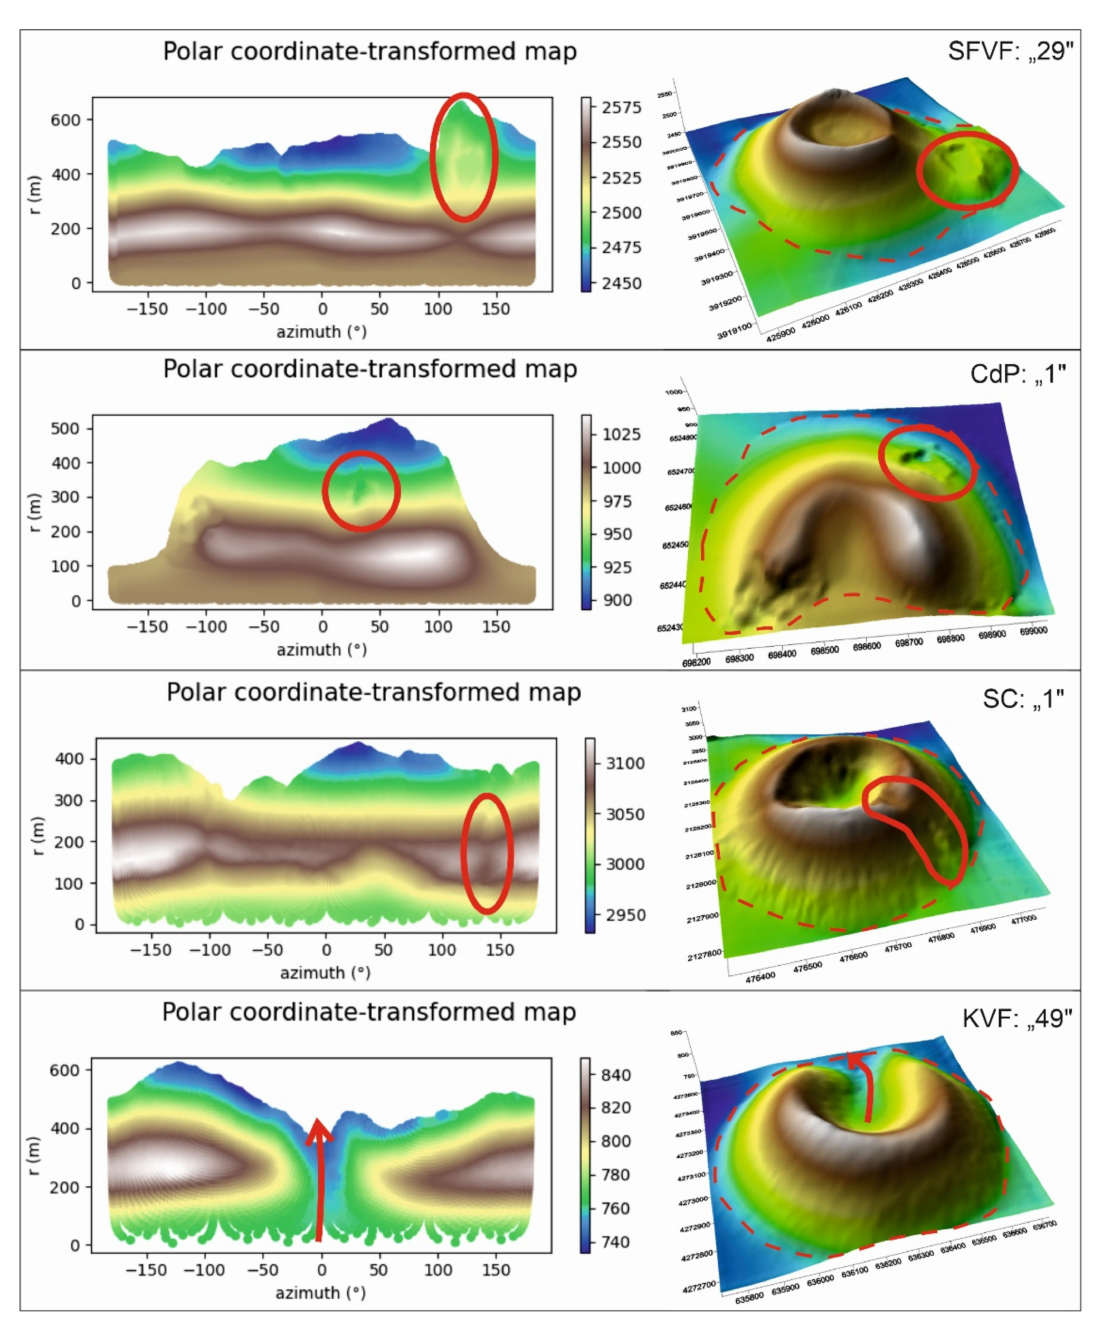
Figure 6. Polar coordinate-transformed maps of four selected cones from each area. The outline of the cones can be seen with a red dashed line; local features are highlighted with a